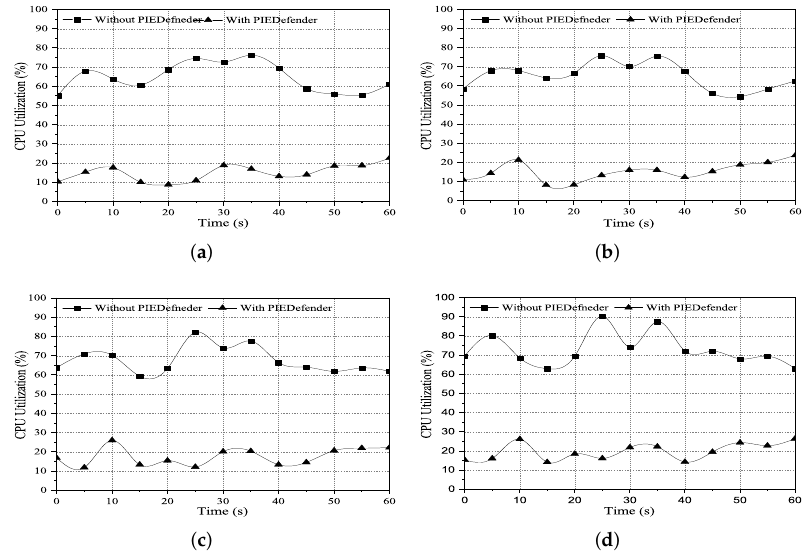
Figure 9. Comparison of controller CPU utilization with and without PIEDefender. ( a ) 50 hosts. ( b ) 100 hosts. ( c ) 150 hosts. ( d ) 200 hosts.